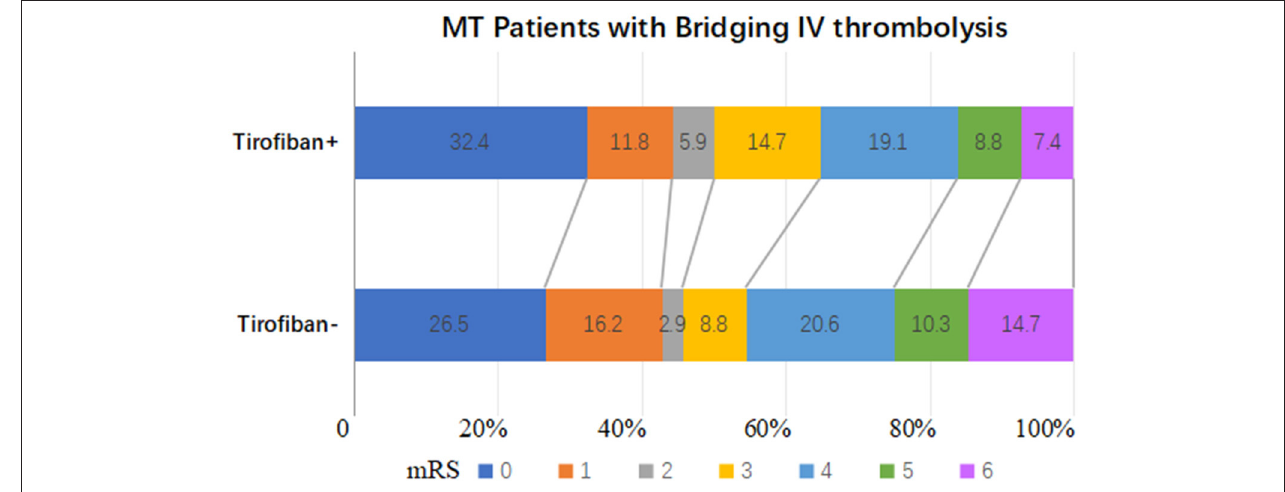
FIGURE 2 | Distributions of the 3-month mRS of patients who underwent mechanical thrombectomy and preceding intravenous thrombolysis after